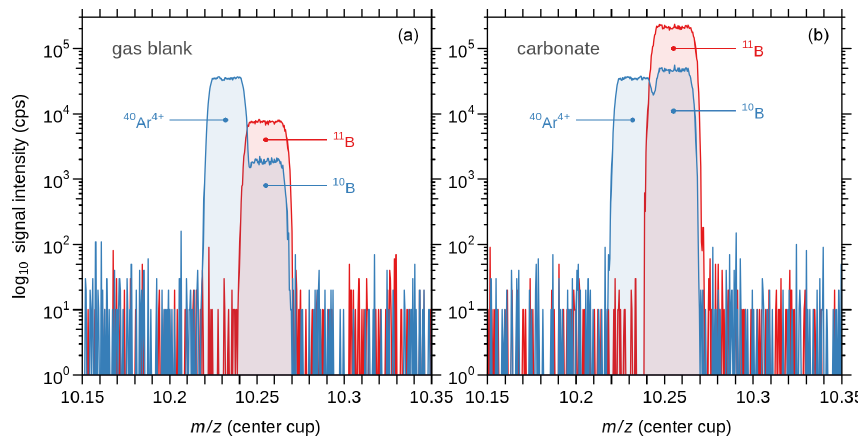
Figure 1. Mass scans over atomic masses 10 (blue) and 11 (red) using Daly detectors, where peak center coincidence appears at ∼ 10 . 25amu in the center cup. (a) Gas blank (laser off), showing the typical double peak of 40 Ar 4 + and 10 B, and the 11 B peak. (b) Signal of ablated calcium carbonate (laser on). The baseline exhibits only electronic noise from the Daly detectors, but no sign of unresolved interferences on 10 B as matrix-induced scattered Ca ion. Note that the signal intensity is on a logarithmic scale.